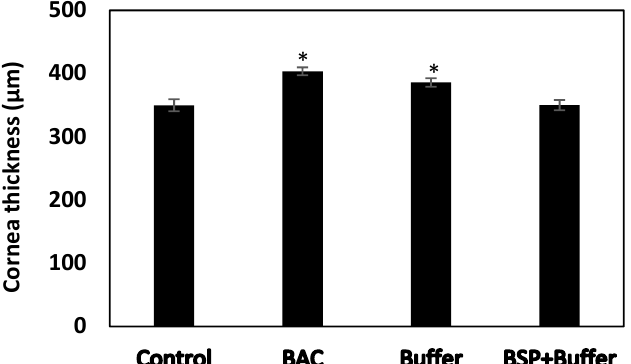
Figure 10. Variation of cornea thickness in rabbits (n = 8), *p < 0.05 compared to control group by one-way ANOVA.